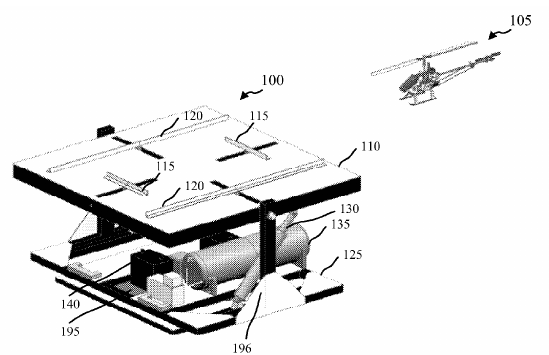
Figure 9. Unmanned aerial vehicle docking station [43] with parallel pushers for UAV positioning by the University of Denver. 105, UAV; 110, landing site; 115, longitudinal pushers; 120, lateral